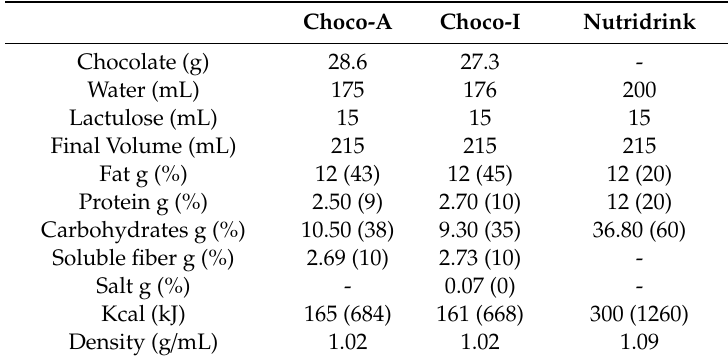
Table 2. Composition of